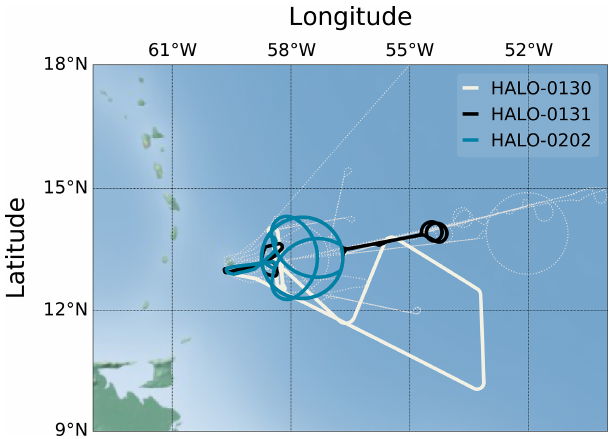
Figure 1. The HALO flight tracks during EUREC 4 A. Flights over long-range-transported Saharan mineral dust are colored. The thin dashed white lines indicate the remaining dust-free research flight tracks.